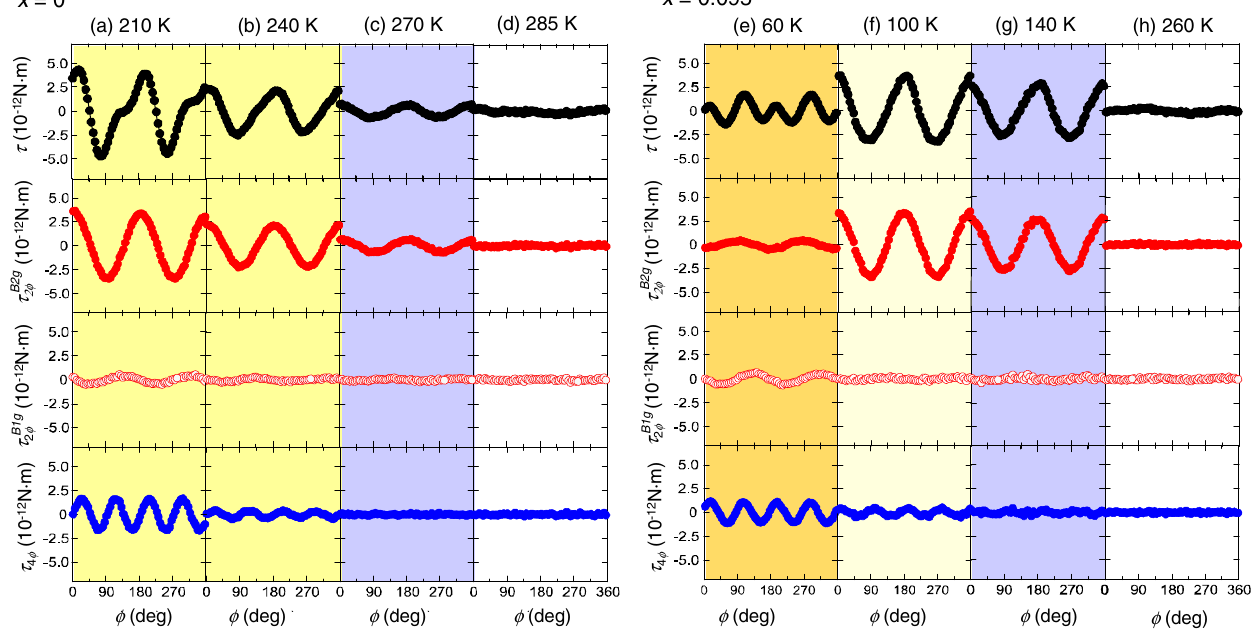
FIG. 7. Rows (a) – (d) and (e) – (h) display the magnetic torque τ ð ϕ Þ in the in-plane magnetic field of j μ 0 H j ¼ 4 T as a function of the ≈ 240 K) and Sr ≈ 120 K and T L ≈ 80 K), respectively. For x ¼ 0 , white, azimuthal angle ϕ for pure Sr 2 IrO 4 ( T 2 Ir 0 . 905 Rh 0 . 095 O 4 ( T S N N N blue, and yellow shaded regions show that the system is in the paramagnetic, hidden-order, and AFM states, respectively. For x ¼ 0 . 095 , the orange (light-yellow) region shows that the system is in the long-range (short-range) AFM state. The top panels show raw torque curves τ ð ϕ Þ . The upper-middle, lower-middle, and bottom panels show the B 2 twofold (cos 2 ϕ ), B 1 twofold (sin 2 ϕ ), and fourfold g g (sin 4 ϕ ) components of the torque curves, respectively, obtained from Fourier analysis of the raw torque